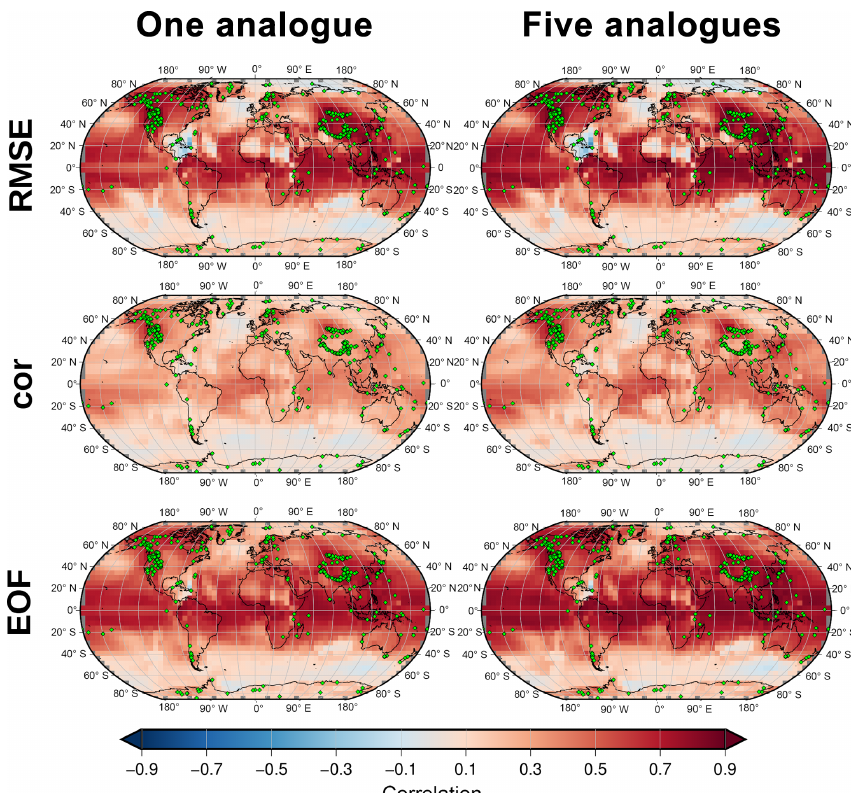
Figure 2. Pointwise correlation (calculated for the whole reconstructed period) between the original simulation and a reconstruction based on perfect pseudo-proxies. The maps show the results when three different metrics are used for the search of analogues (by rows), as well as when different numbers of analogues are combined to draw the reconstruction (by columns). Green diamonds indicate the location of the pseudo-proxies employed, based on the PAGES-SEL